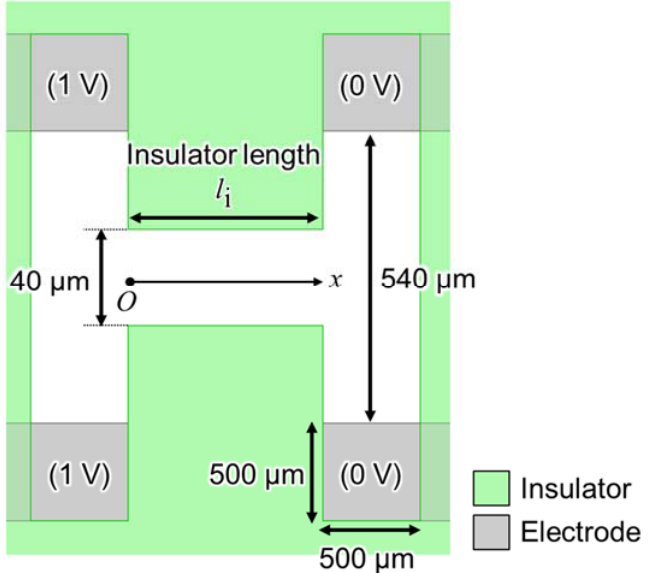
Figure 2. Top view of the device with parallel insulators for analyzing the generated electric field properties.